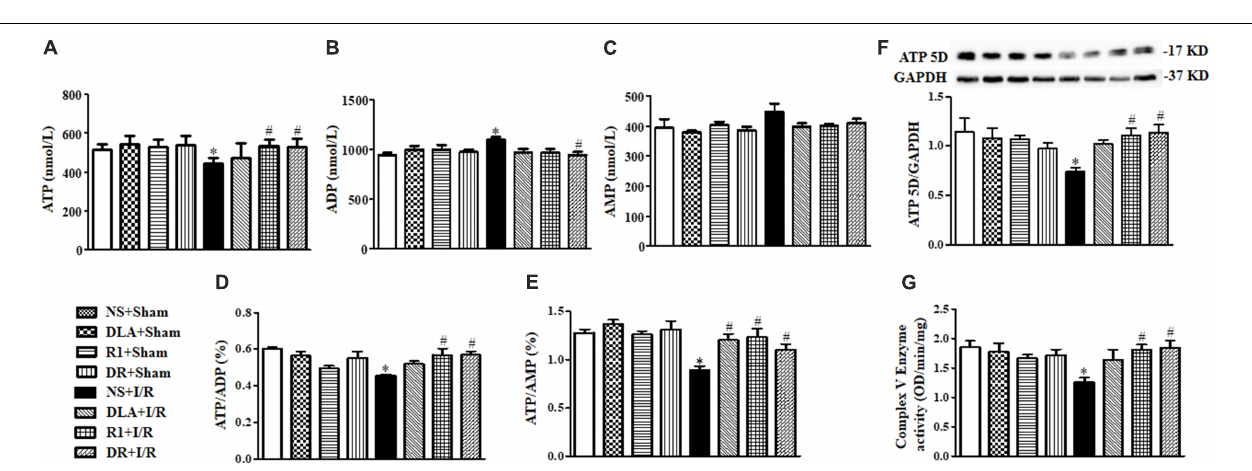
FIGURE 9 | The effect of DLA, R1, and DR pretreatment on myocardial energy metabolism, the Mitochondrial Complex V (Complex V) enzyme activity, and ATP 5D expression in rats after I/R for 90 min. (A–C) Quantitative evaluation of adenosine triphosphate (ATP), adenosine diphosphate (ADP), and adenosine monophosphate (AMP) by ELISA in myocardial tissue. (D and E) Quantitative evaluation of ATP/ADP and ATP/AMP in myocardial tissue. Data are expressed as means ± SEM (n = 6). * p < 0.05 vs. sham group, # p < 0.05 vs. I/R group. (F) Representative Western blot bands of ATP 5D in various groups with quantitative results shown below. Quantitative results for ATP 5D band intensities were normalized to GAPDH (n = 6). (G) Complex V activity determined according to the slope of increase in OD at 450 nm in all groups (n = 6). Data are expressed as means ± SEM (n = 6). * p < 0.05 vs. NS + Sham group; # p < 0.05 vs. NS + I/R